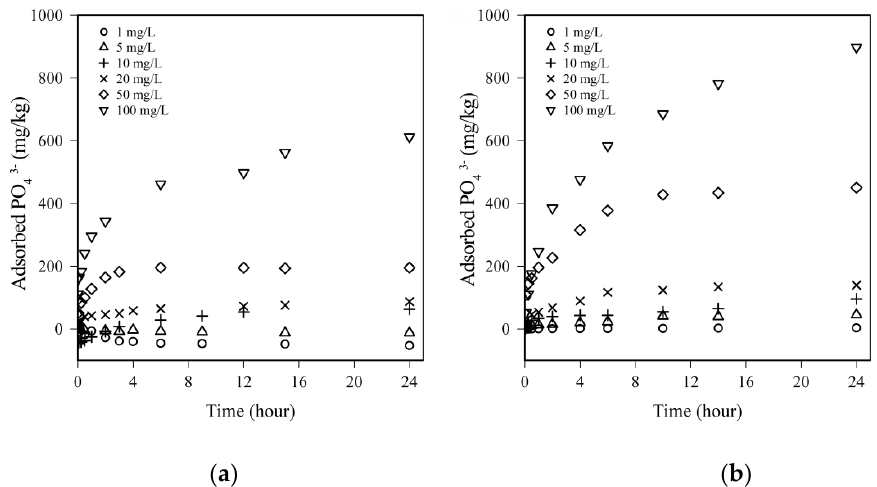
Figure 3. The effect of initial phosphate concentration on the phosphate sorption dynamic employing the diffusion approach with ( a ) fine earth and ( b ) soil aggregates (topsoil).